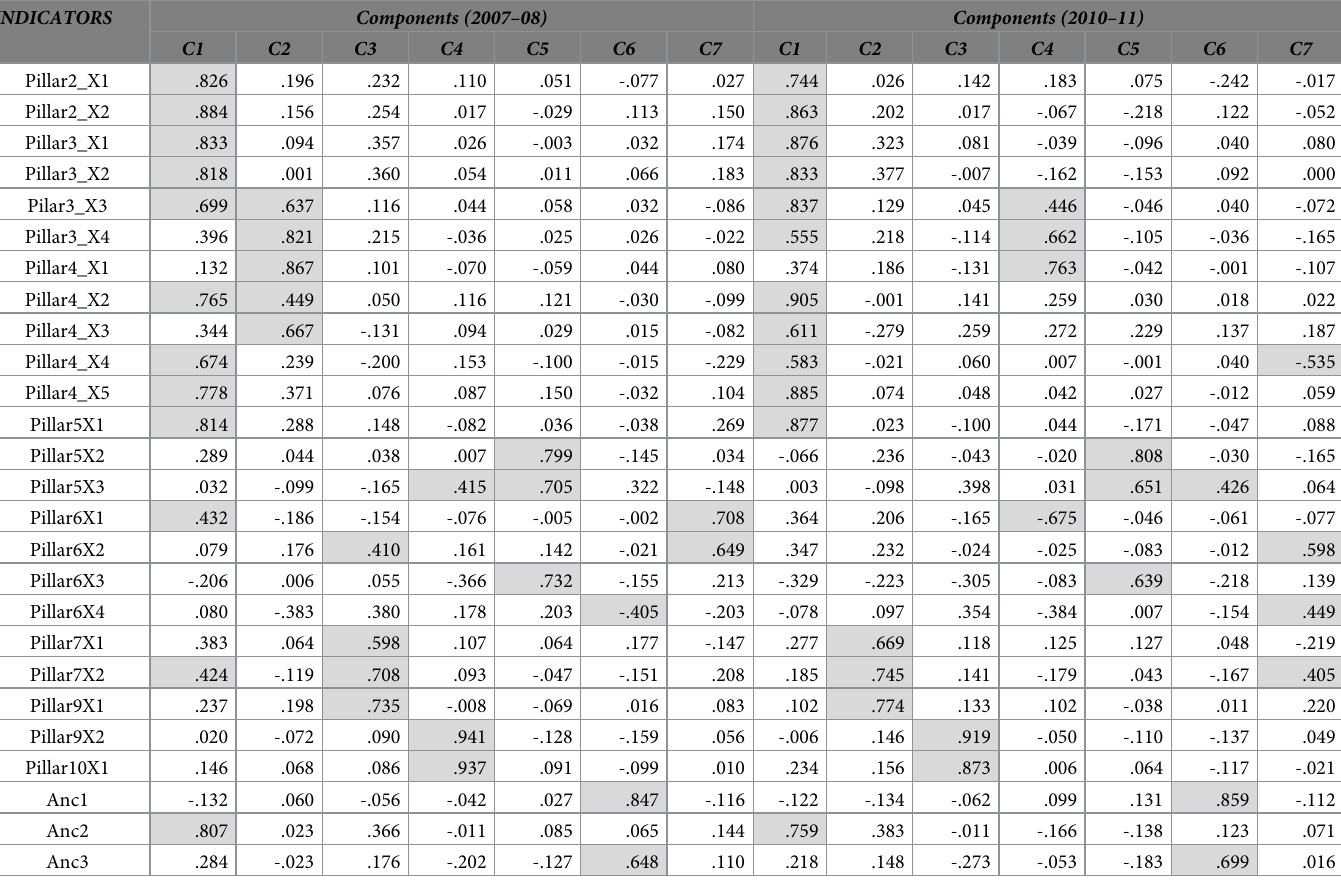
Table 5. Matrix of rotated components. Rotation method: